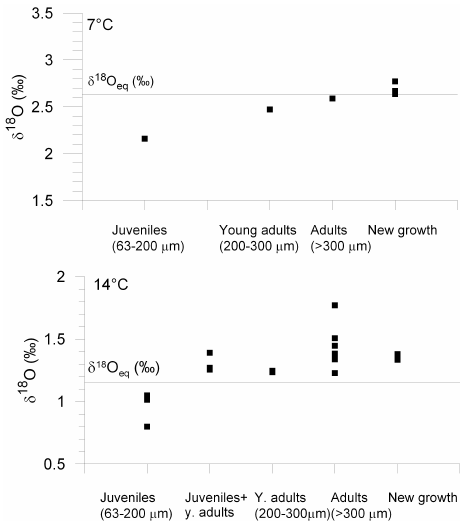
Fig. 5. Mg/Ca (mmol/mol) over the experimental temperature gra- dient, presented by sample type (new growth and size classes). For 7 and 14 ◦ C, data is presented in two columns to allow visualization of result from different samples types, see legend for details.